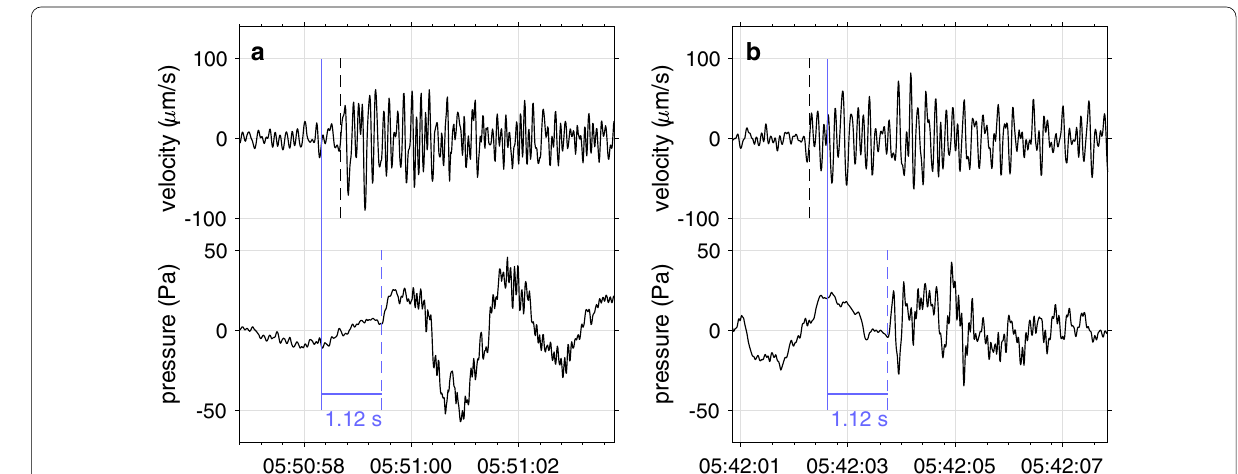
Fig. 10 Example waveforms of seismo-acoustic signals. These waveforms have a a short time delay and b a long time delay of the arrivals. Dashed lines are the arrival times read manually. The solid line shows the time 1.12 s before the infrasound arrival. The maximum value of the time delay that can be reproduced by our model is 1.12 s. However, the time delay of example b seems to be longer than 1.12 s. Perhaps the initial phase of the infrasound signal was not excited well, causing the time delay to appear to be